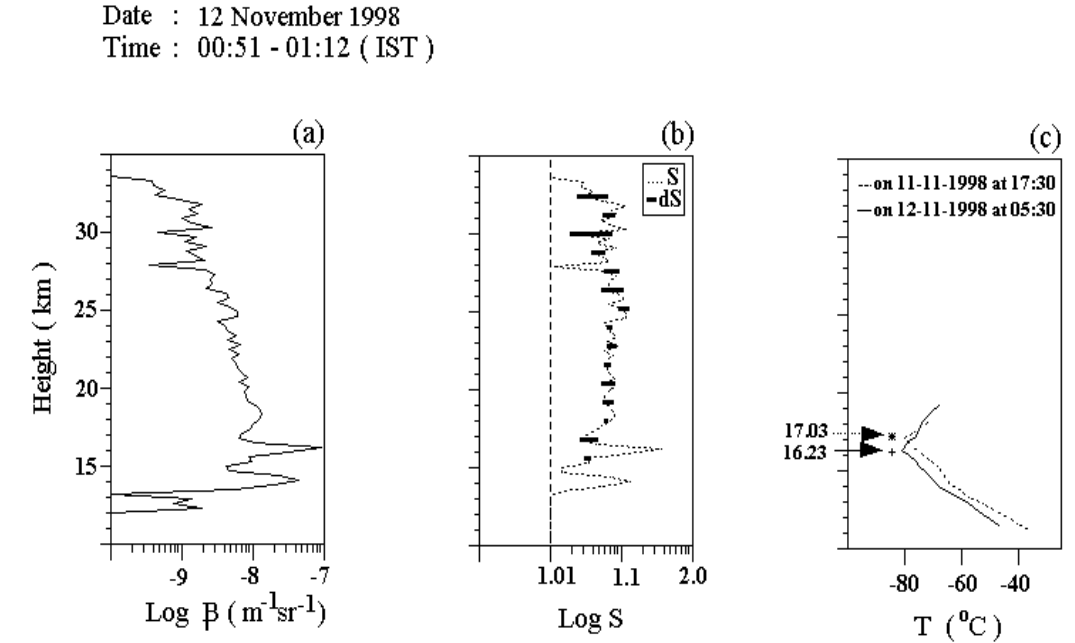
Fig. 1. Height profile of (a) Lidar co-polarized attenuated backscatter coefficient. (b) Attenuated backscatter ratio with error bars show two cirrus returns one at 14km and the other at 16km in the vicinity of the tropopause and the above is the stratospheric aerosol. (c) Radiosonde temperature profiles obtained from the nearest meteorological station at 17:30 h IST on 11 November and 05:30 h IST on 12 November 1998. Arrows show that cold point tropopause is detected using these temperature